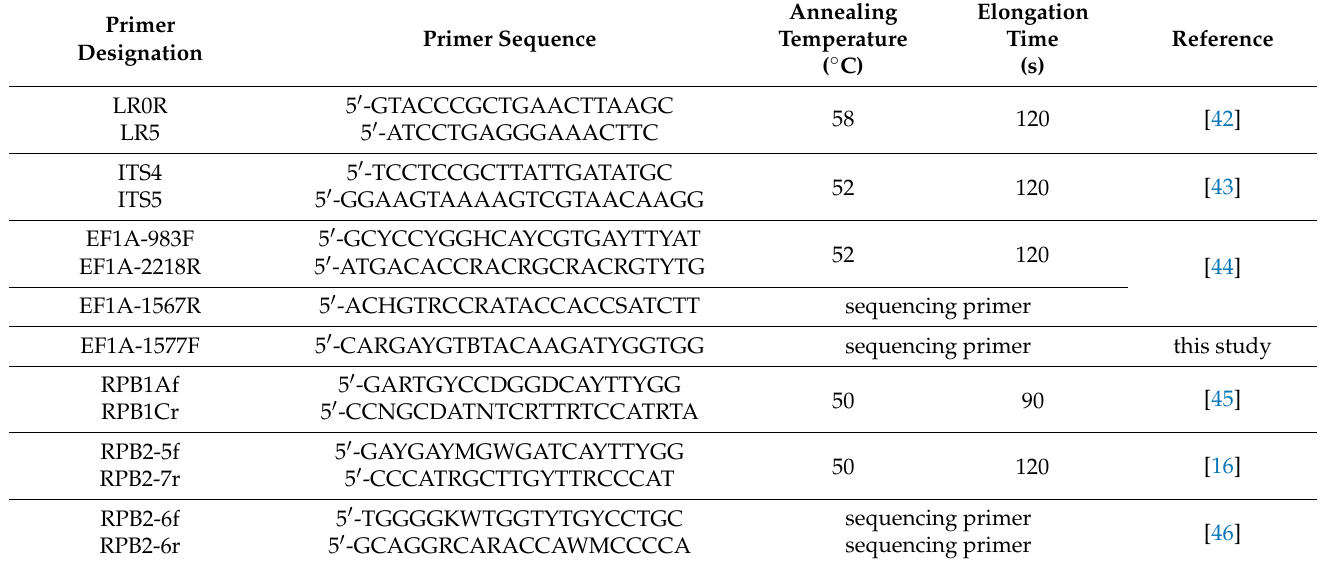
Table 1. PCR primers and parameters used in this